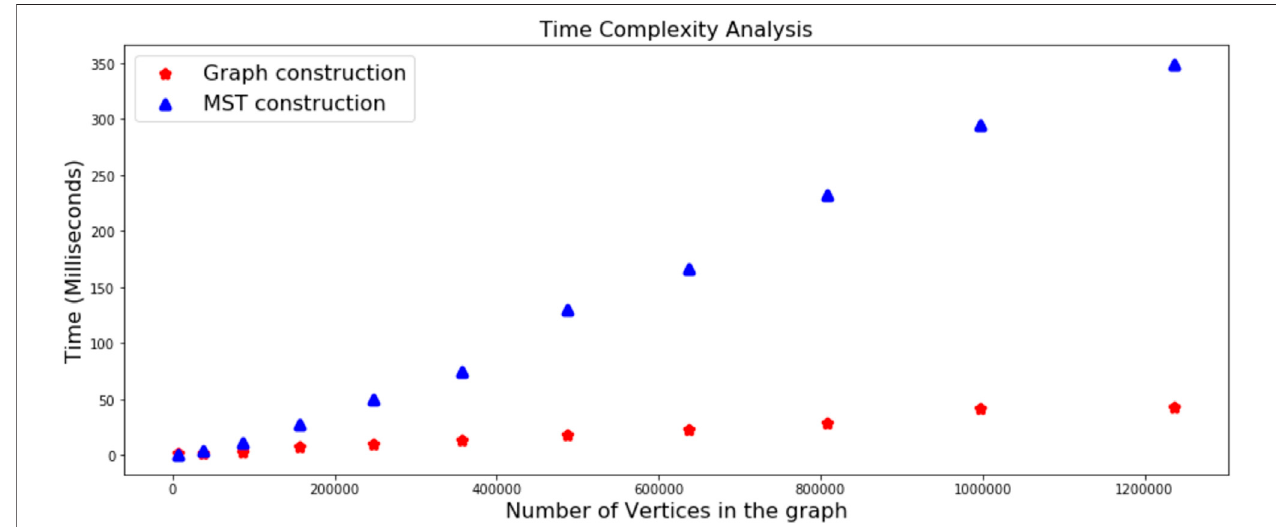
FIGURE 10 | Time complexity analysis. The time spent on graph construction is less than the time spent on minimum spanning tree (MST) construction. The computation time increases based on the size of the input image.